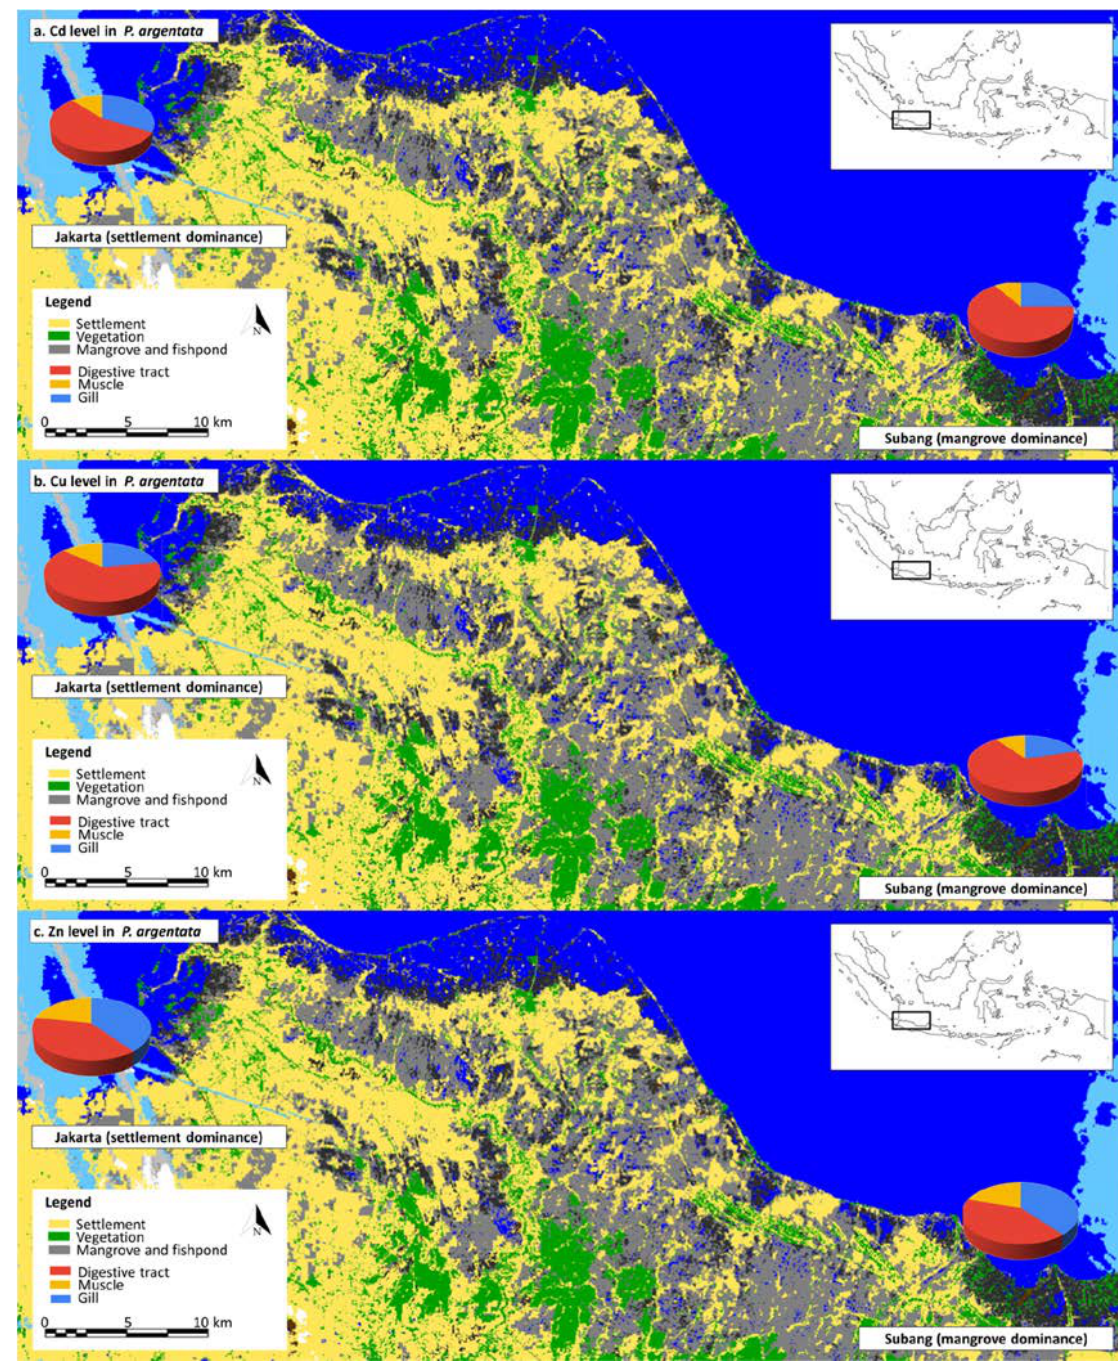
Fig. 3: Cd (a), Cu (b), and Zn (c) level compositions (pie charts) in gills, digestive tracts, and muscles of P. argentata related to land uses in Jakarta in the west (settlement dominance) and Subang in the east (mangrove dominance) in West Java coast, Indonesia